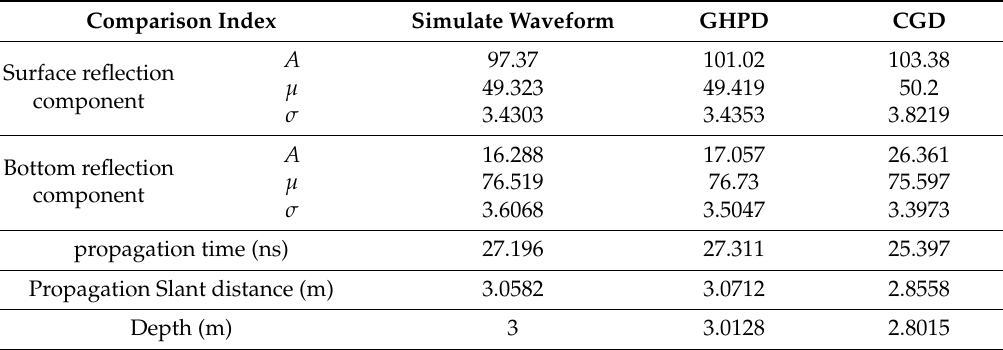
Table 5. Effect comparison of the GHPD and the CGD.